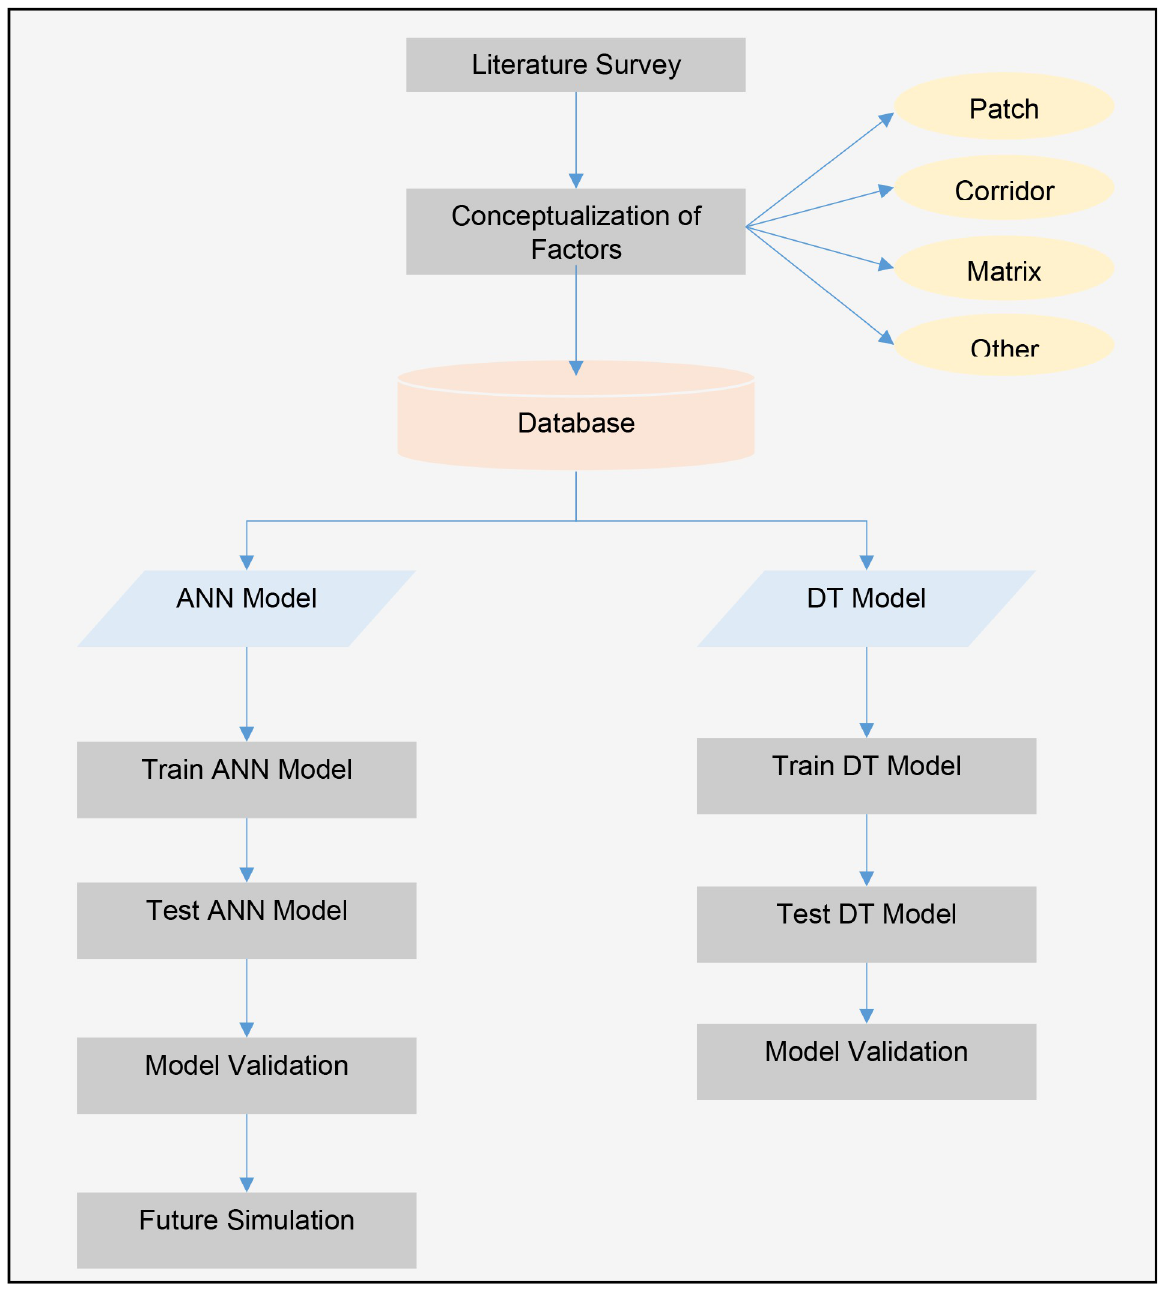
Fig 2. Steps of research